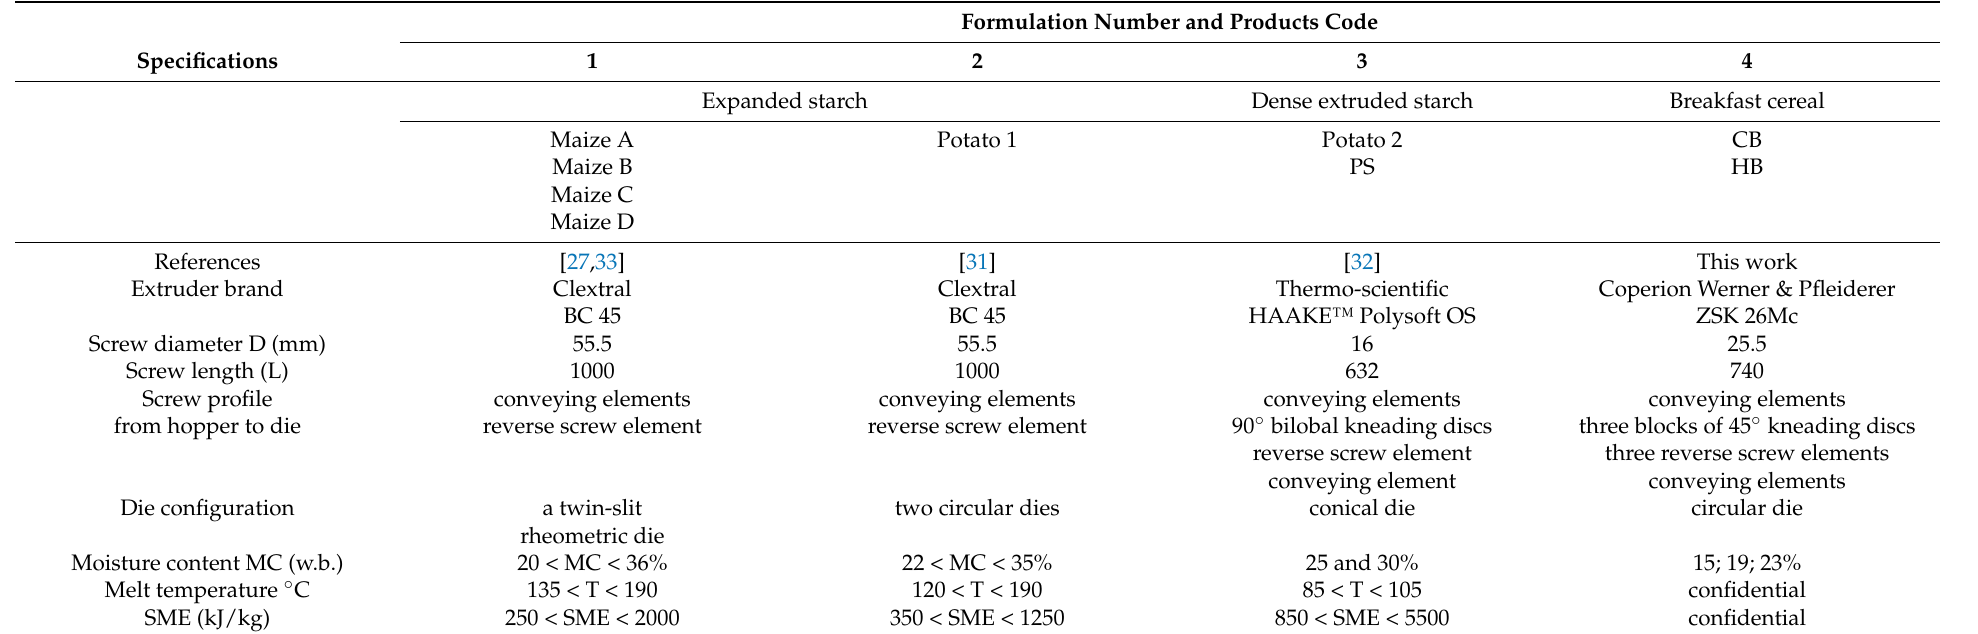
Table 2. Database of extrusion operating conditions and